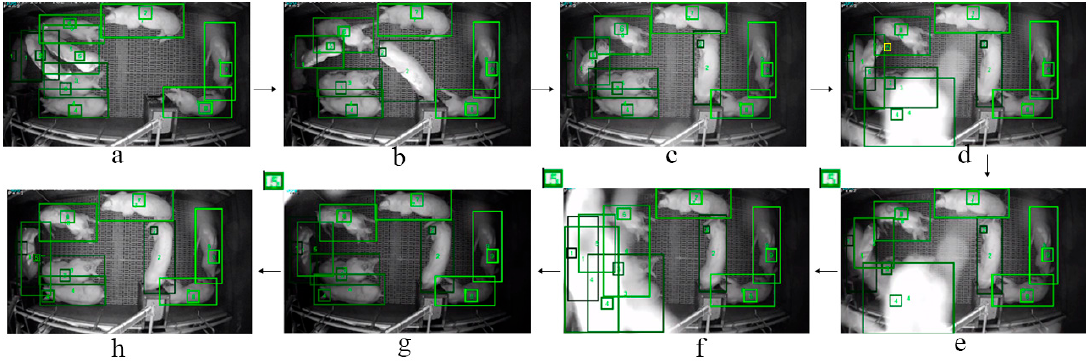
Figure 8. The example detection and tracking results of our method in the night video with a severe occlusion of insect. The sequence order is from frame ( a ) to ( h ).